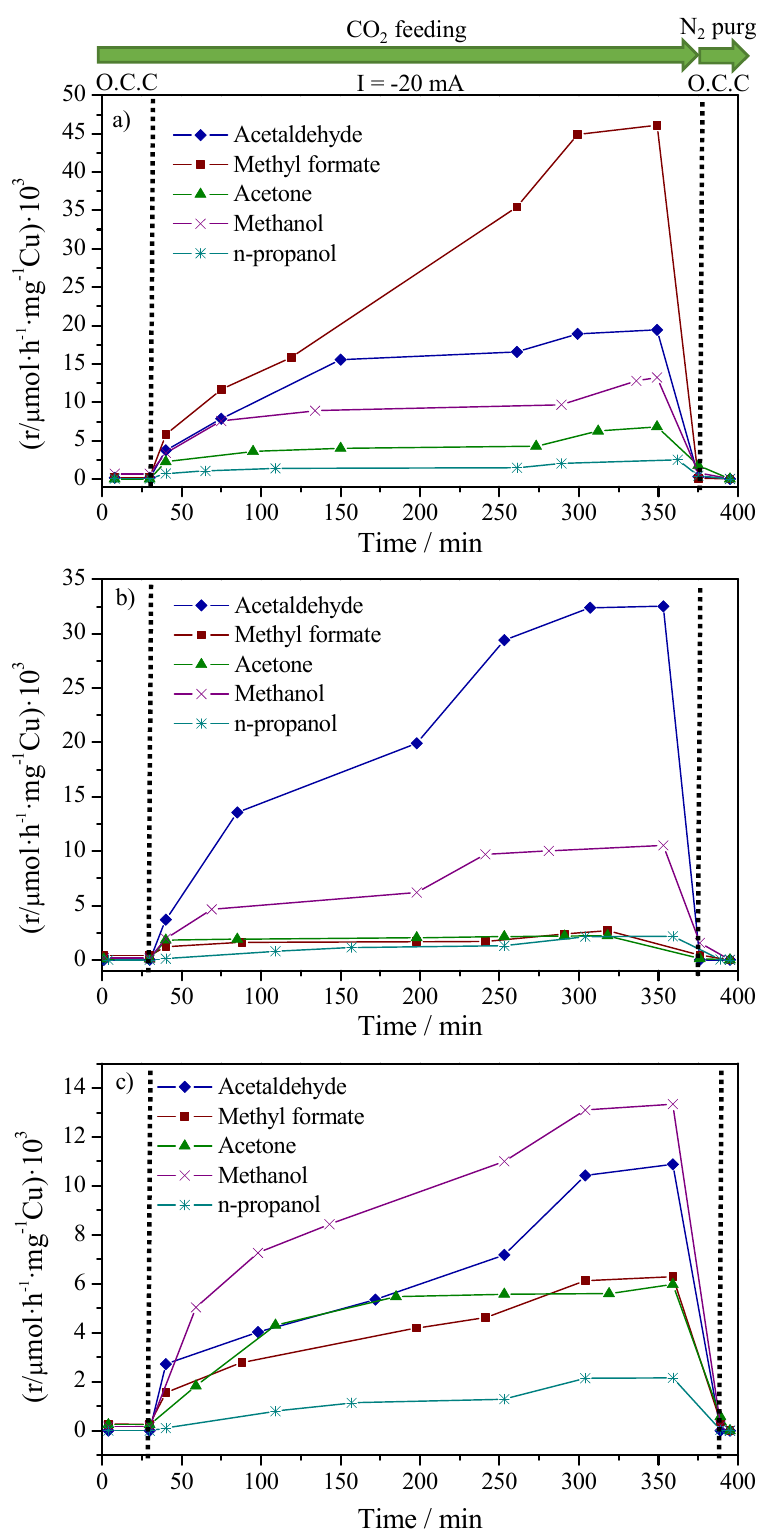
Figure 3. Time-on-stream variation of the rate of production for the different products at a constant current of −20 mA over the cathodic-catalysts on carbon paper substrates: ( a ) 50% Cu-AC, ( b ) 20% Cu-AC, and ( c ) 10% Cu-AC. Conditions: temperature = 90 °C , F_( CO_2 ), cathode = 1.65 NmL·min −1 y F_( H_2O ), anode = 6 NmL·min −1 .